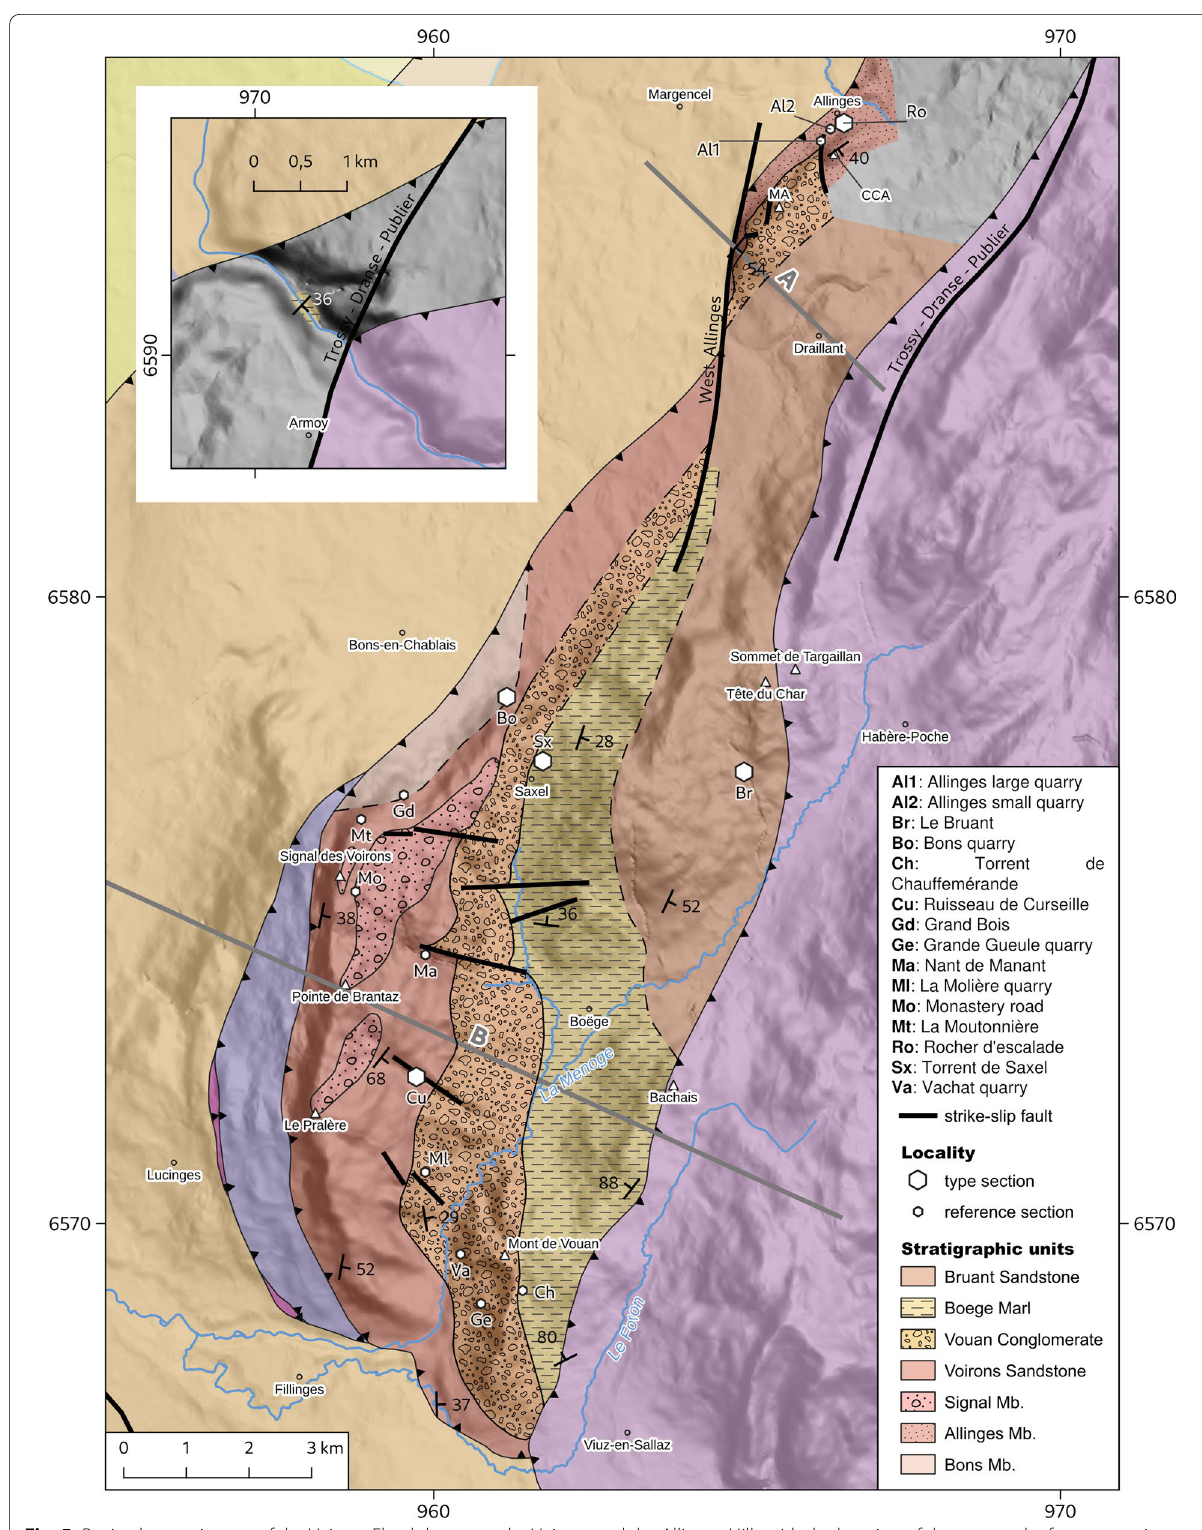
Fig. 5 Revised tectonic map of the Voirons Flysch between the Voirons and the Allinges Hills with the location of the type and reference sections. The northern portion beyond the Dranse River is not shown due to the lack of constrains. The geometry along the Allinges Hills is hypothetical in the absence of subsurface data. The Bruant Sandstone is interpreted here as a stratigraphic